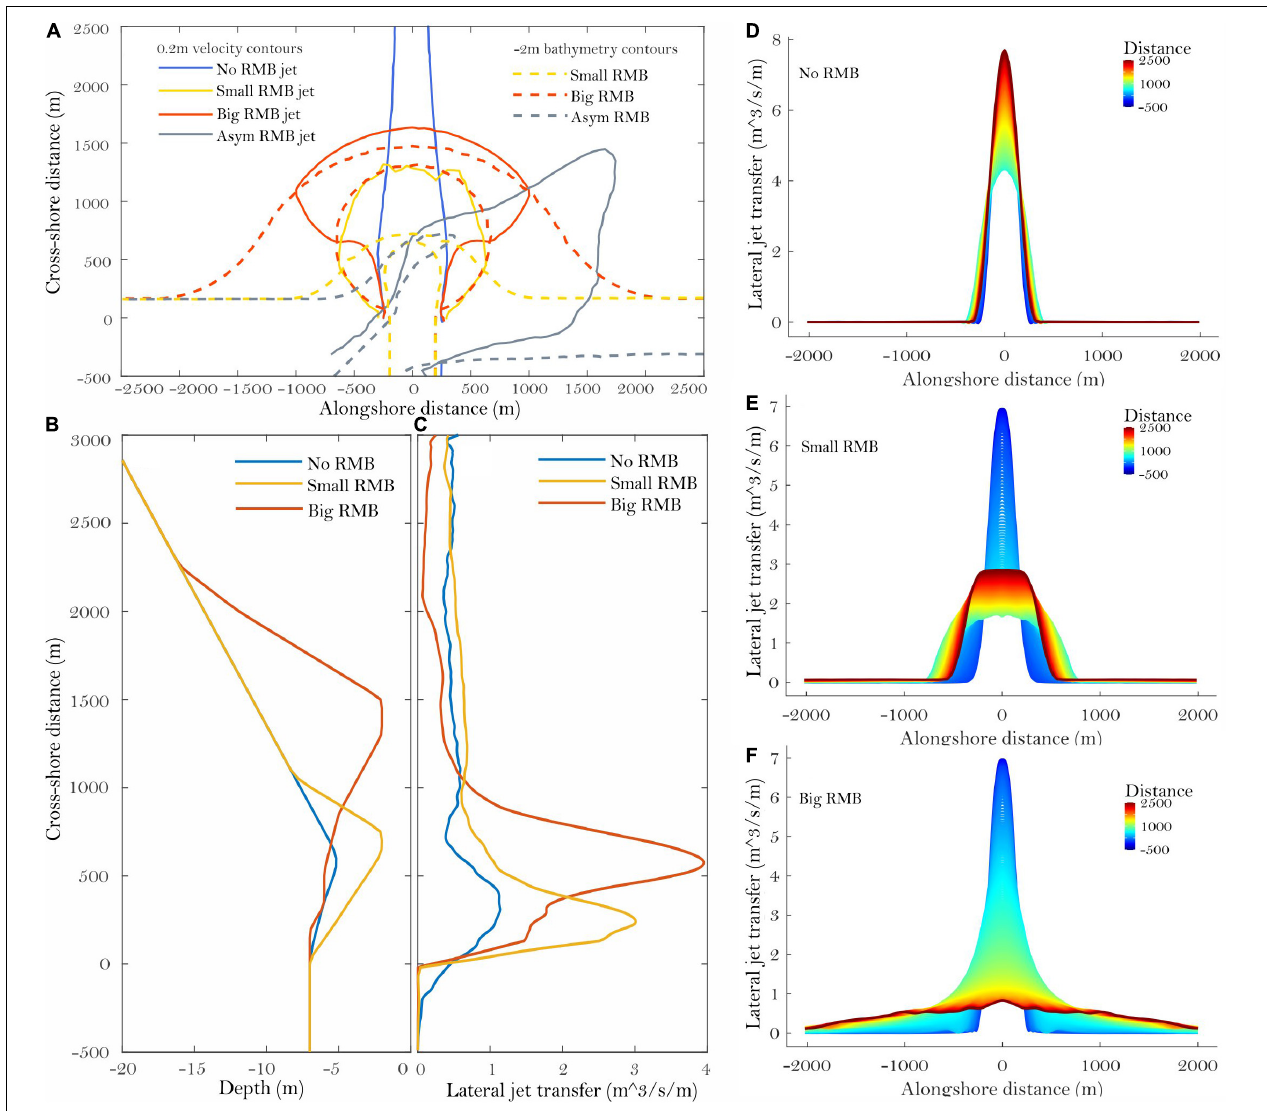
FIGURE 3 | Influence of RMB types on jet spreading. (A) shows the contours of 0.2 m/s velocities plotted for the different jets. (B) and (C) show the bathymetric profiles on jet centerline and the lateral jet transfer rate ( LJT ). (D–F) illustrate the change in jet structure evidenced by the discharge (m 3 /s) in relation with the three types of RMB; colors represent increasing cross-shore distance (m); the river outlet located at 0. Prot45 RMB is not shown because spreading is similar to Big RMB